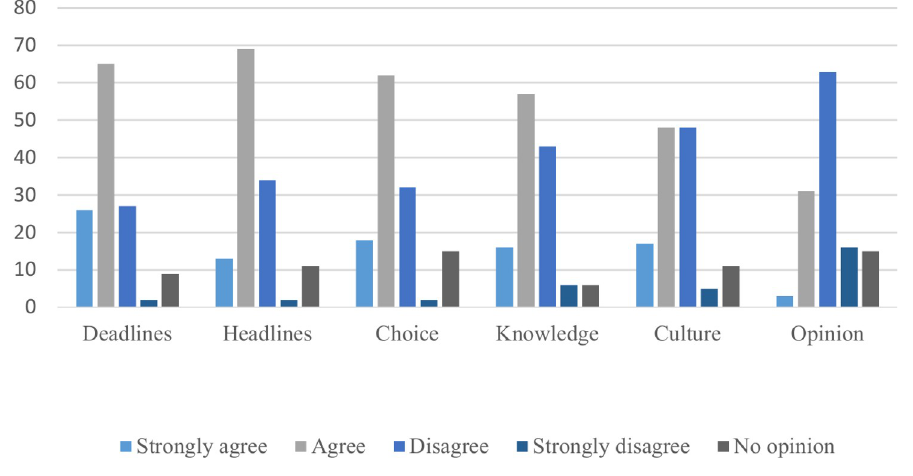
Fig 1. Experts’ assessments of problems in media contacts.